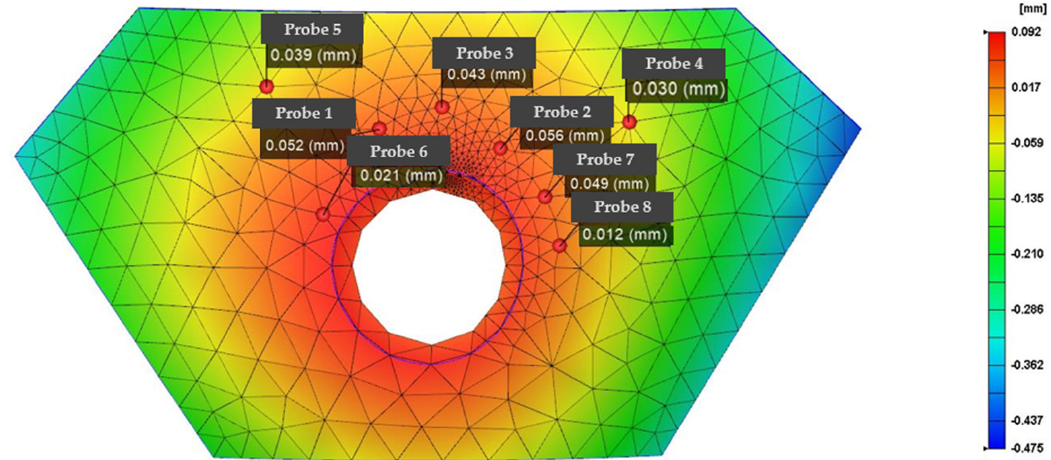
Figure 7. Optimized armor stamping index analysis data graph.